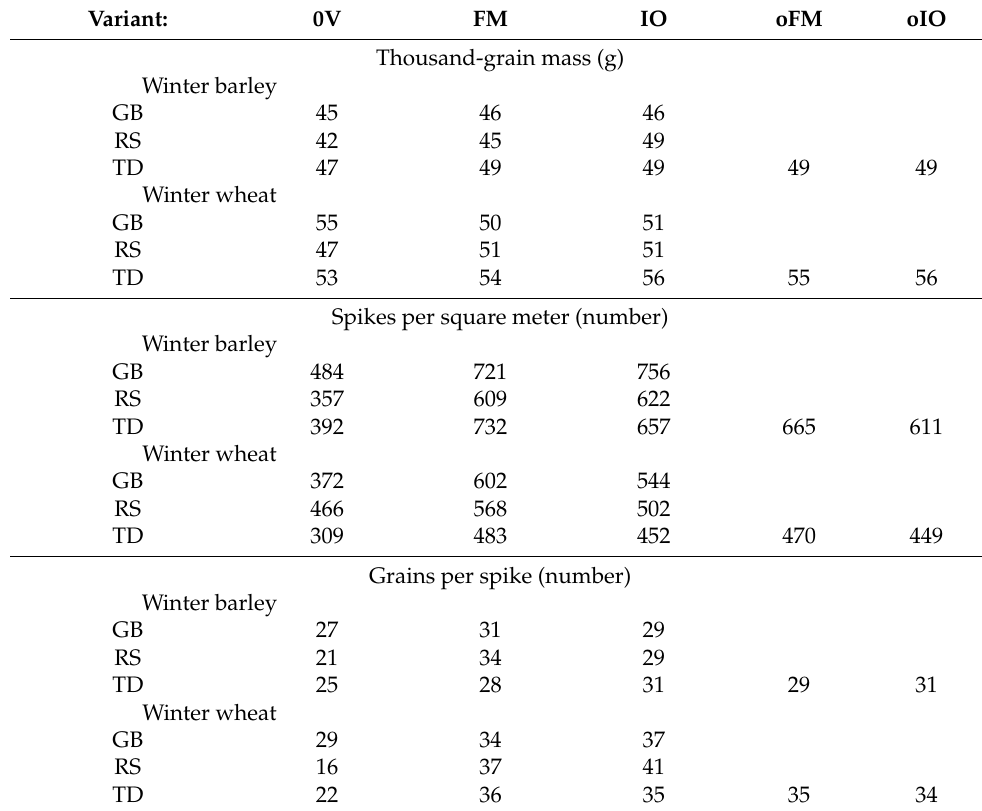
Table 6. Yield components of winter barley and winter